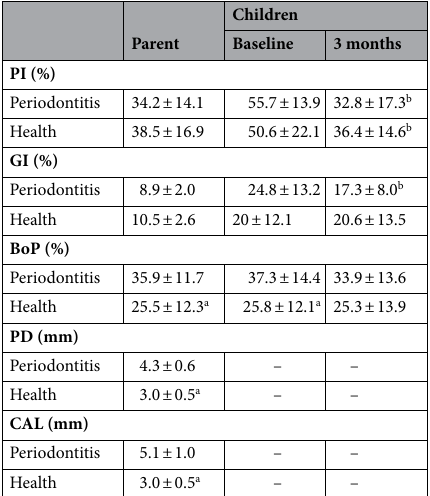
Table 1. Clinical data on children and their parents. SD, Standard deviation; PI, Plaque Index; GI, Gingival Index; PD, Probing depth; BoP, Bleeding on probing; CAL, Clinical Attachment Leve. a Represents differences between Periodontitis and Health groups ( p < 0.05, Mann–Whitney test). b Represents differences between Baseline and 3 months for children from each group ( p < 0.05, Wilcoxon